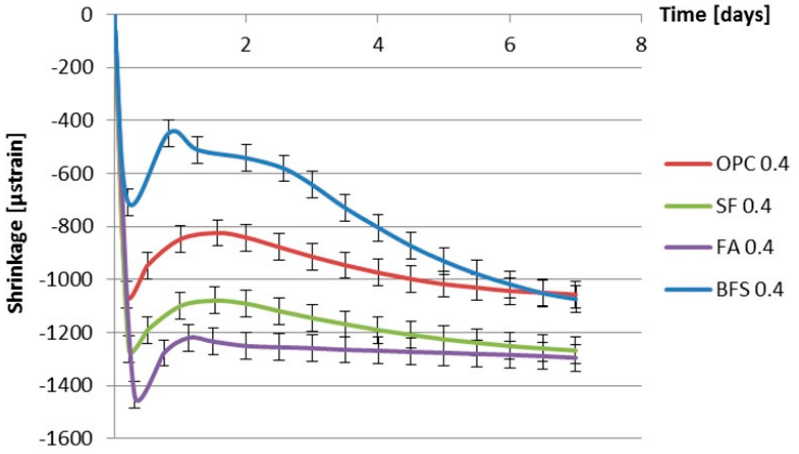
Figure 13. Autogenous deformation vs. age for different cement pastes with water–binder ratio of 0.4 (starting time: final setting time).